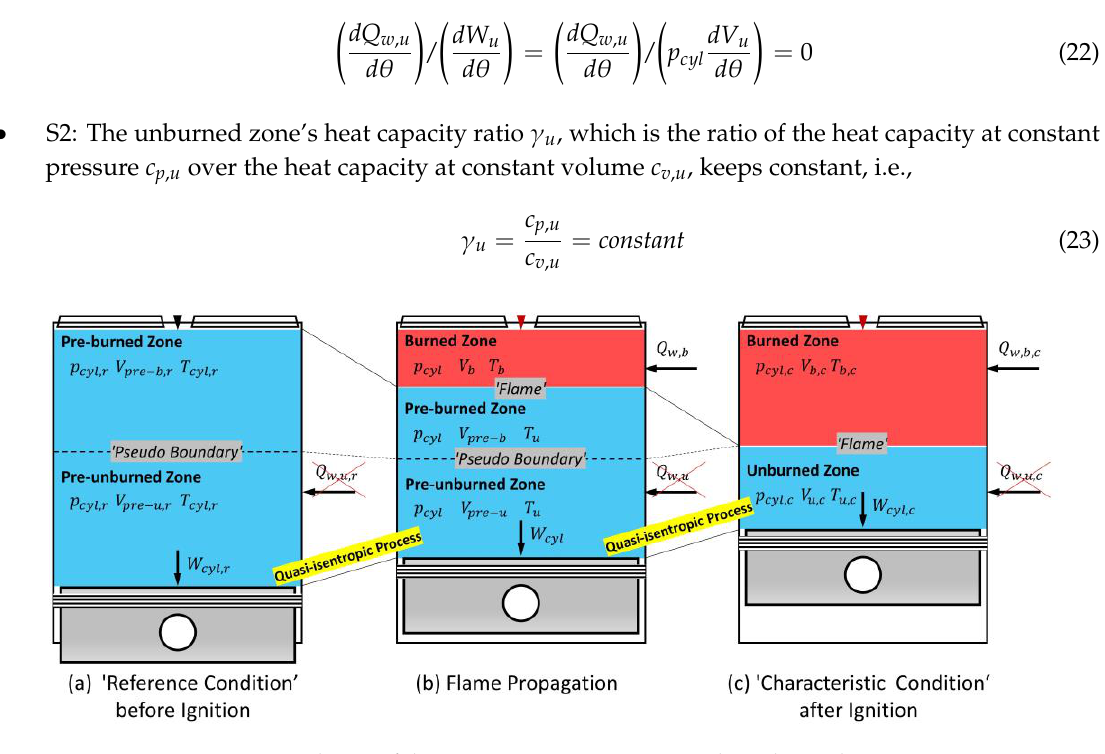
Figure 4. Isolation of the quasi-isentropic process in the unburned zone.